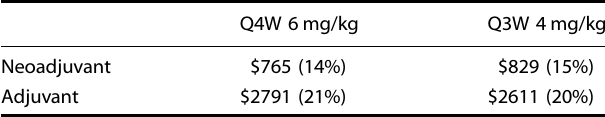
Table 2. Per-patient Savings for reduced-frequency trastuzumab compared to current standard-of-care dosing (Q3W, 6